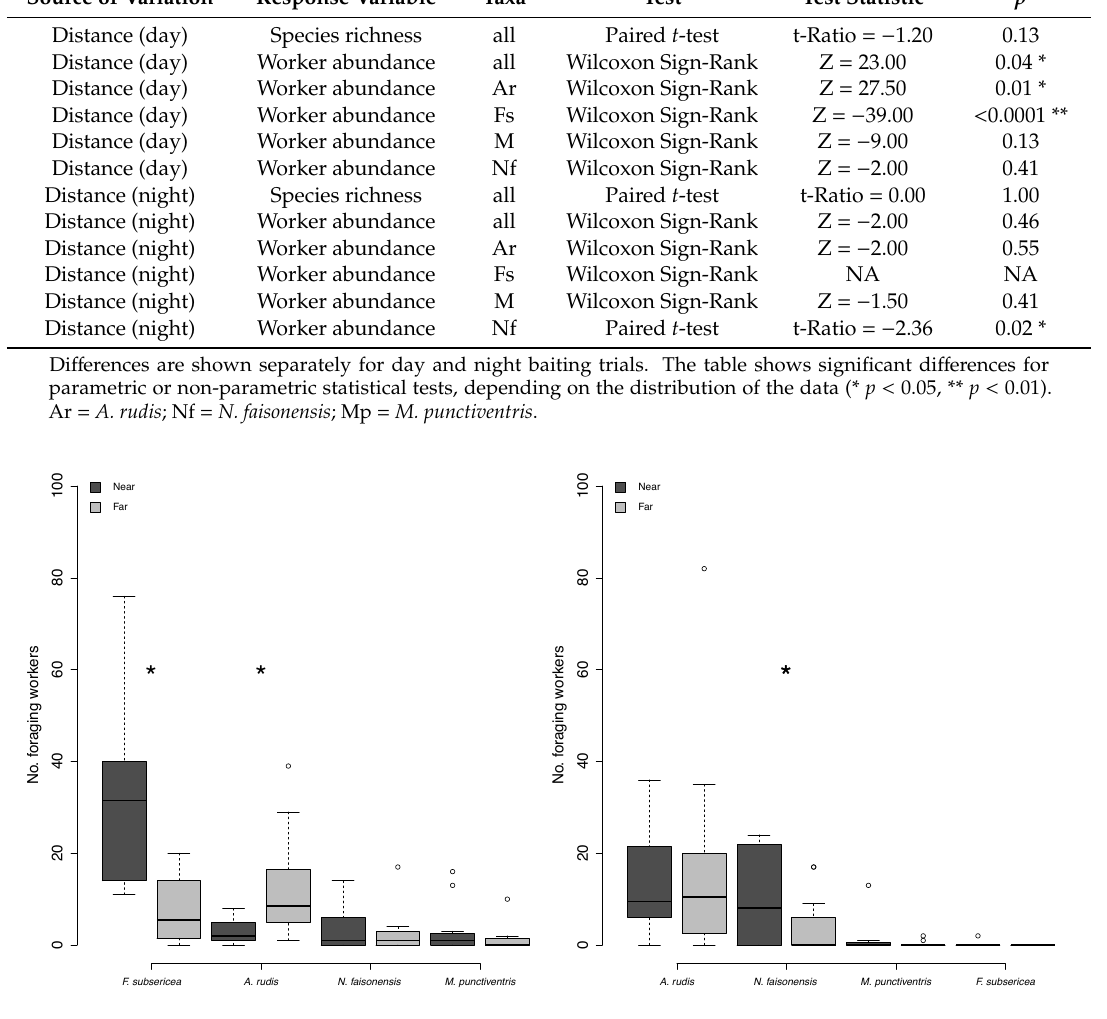
Figure 3. Mean number of workers of A. rudis, M. punctiventris and N. faisonensis recorded on baits near and far from focal nests of dominant F. subsericea ( a ) during the day and ( b ) at night. Asterisks indicate significant di ff erences between near and far baits ( p < 0.05).